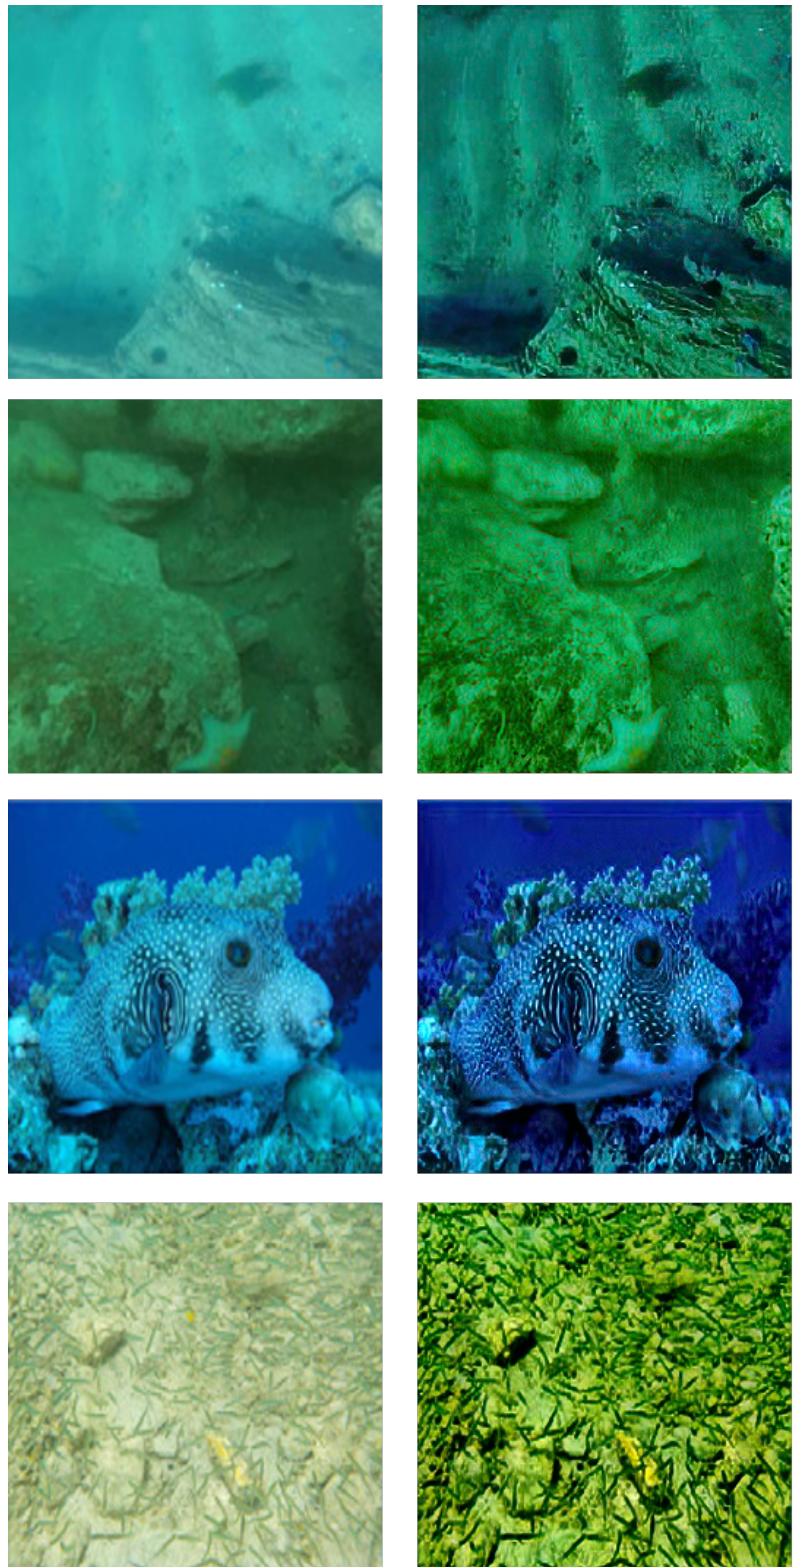
Figure 9. Visual comparison of natural underwater images. From left to right are raw underwater images, and proposed images. The proposed images were compared with the results from Ancuti [11], Guo [36], Berman [37], Cosman [8], Zhuang [19], gl [38]. The images are sourced from